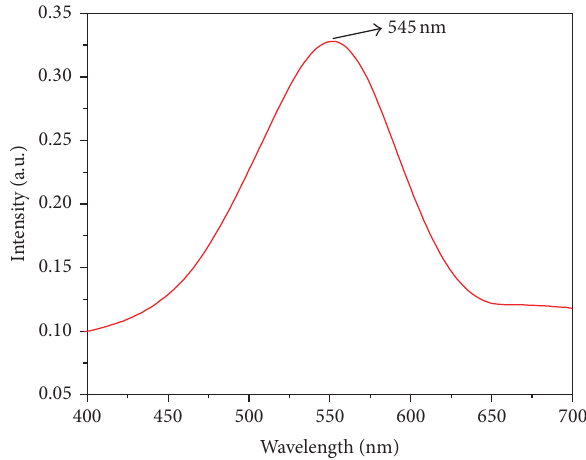
Figure 8: Fluorescence emission spectra of as-synthesized CuO nanoparticles in ethanol